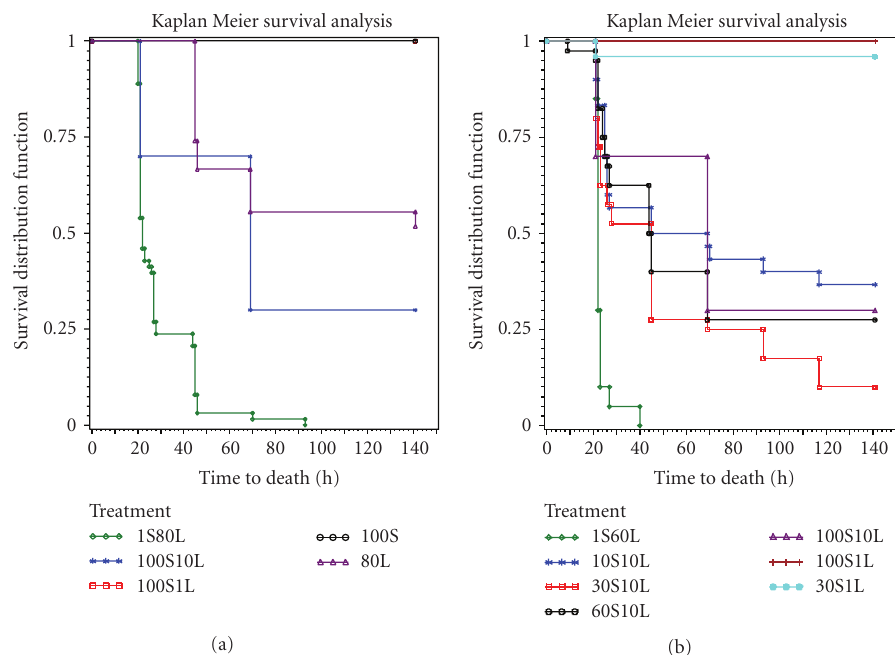
Figure 1: Survival analysis of BALB/c mice treated with (a) 1 μ g SEB plus 80 μ g LPS ( n = 63), 100 μ g SEB plus 10 μ g LPS ( n = 10), 100 μ g SEB plus 1 μ g LPS ( n = 10), 100 μ g SEB ( n = 10), and 80 μ g LPS ( n = 27). (b) 1 μ g SEB plus 60 μ g LPS ( n = 20), 10 μ g SEB plus 10 μ g LPS ( n = 30), 30 μ g SEB plus 10 μ g LPS ( n = 40), 60 μ g SEB plus 10 μ g LPS ( n = 40), 100 μ g SEB plus 10 μ g LPS ( n = 10), 30 μ g SEB plus 1 μ g LPS ( n = 25), and 100 μ g SEB plus 1 μ g LPS ( n =